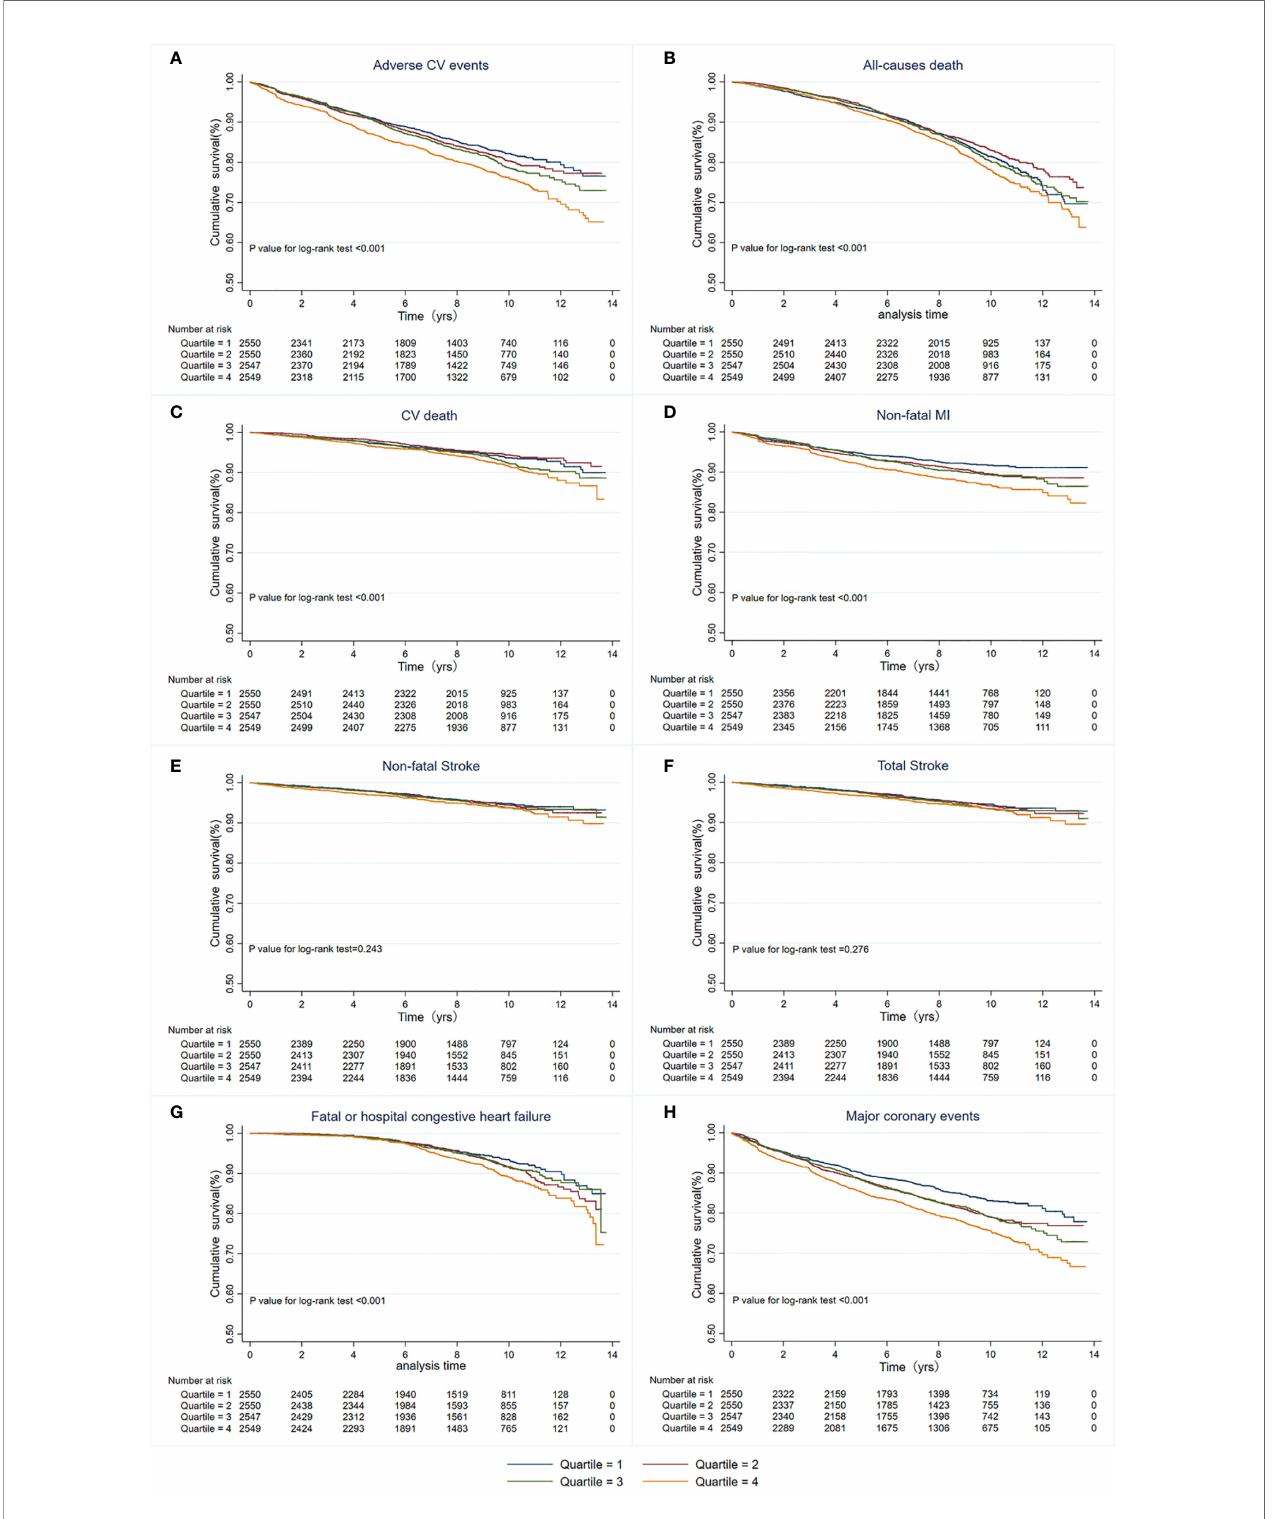
FIGURE 1 | Kaplan-Meier survival curves for primary and secondary outcomes based on quartiles of baseline TyG index. (A) MACEs; (B) All-cause death; (C) CV death; (D) Non-fatal MI; (E) Non-fatal stroke; (F) Total stroke; (G) Fatal or hospital congestive heart failure; (H) Major coronary events. MACEs, Major adverse cardiovascular events; CV, Cardiovascular; MI, myocardial